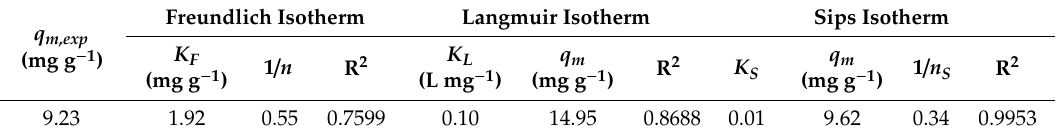
Table 1. Parameters of isotherm models for adsorption of palladium ions onto MgSiO 3 -cys. q m,exp (mg g − 1 )